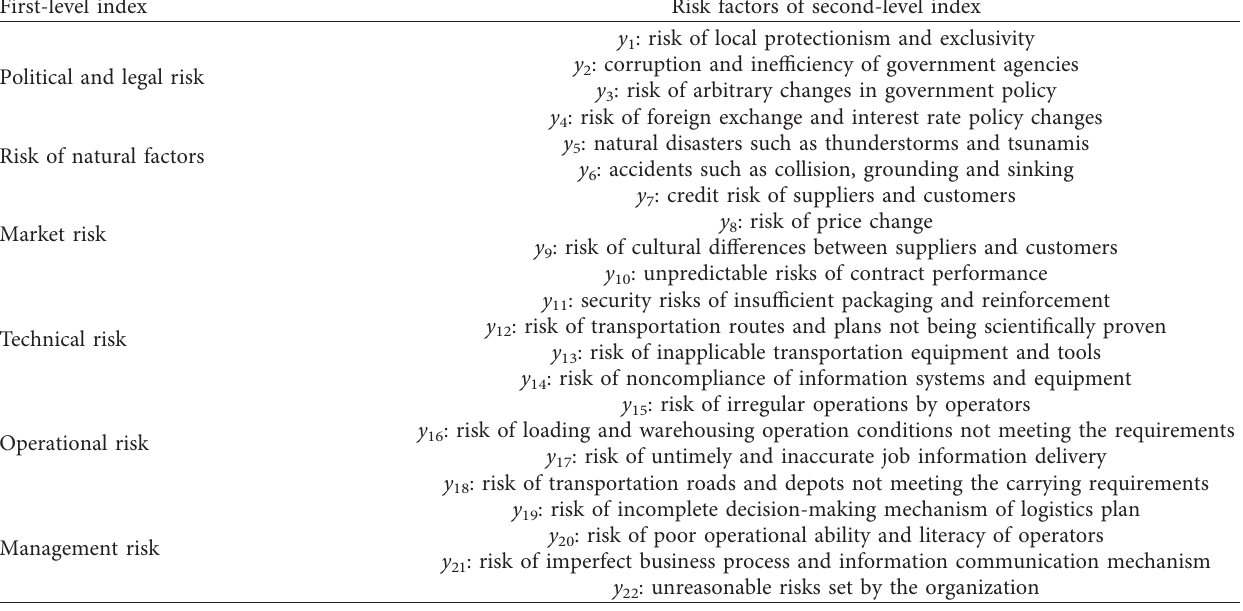
Table 1: Logistics risks of overseas EPC projects.